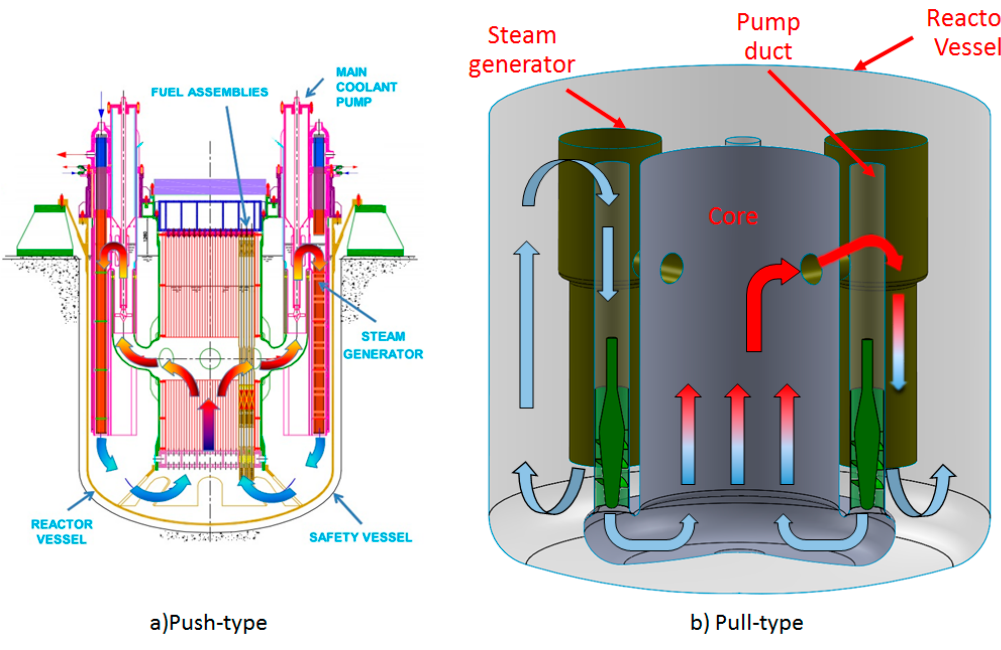
Figure 2. ( a ) push-type configuration; ( b ) pull-type pump configuration.